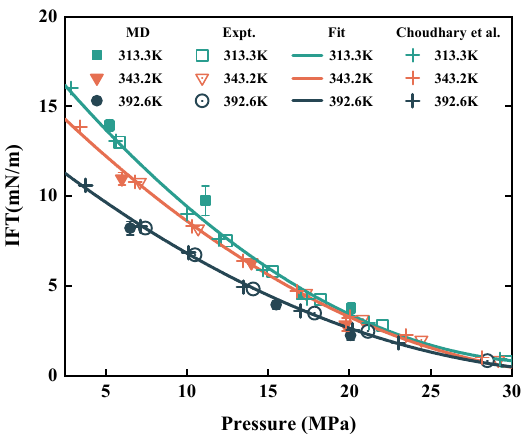
Figure 7. IFT of CH 4 /n-decane at different temperatures. The solid symbols represent the results from the MD simulations, experimental results of Pereira [13] are shown as open symbols, and the plus sign indicates the results of MD simulations by Choudhary et al. [22].